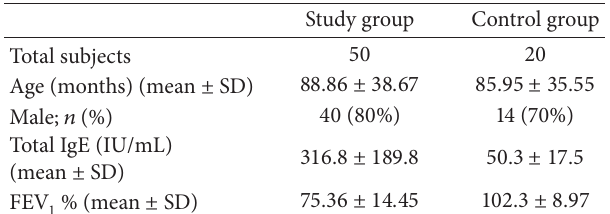
Table 1: Patients